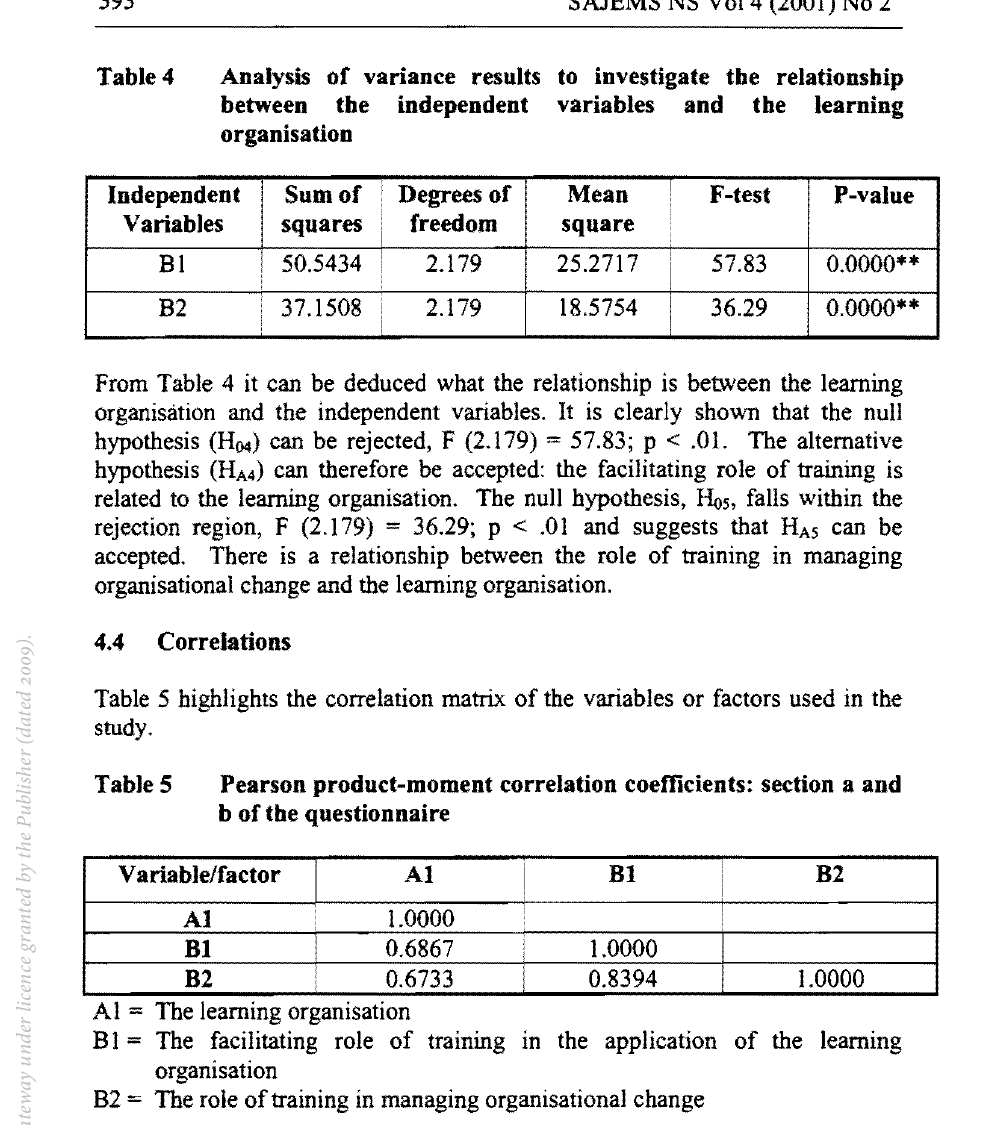
Pearson product-moment correlation coefficients: section a